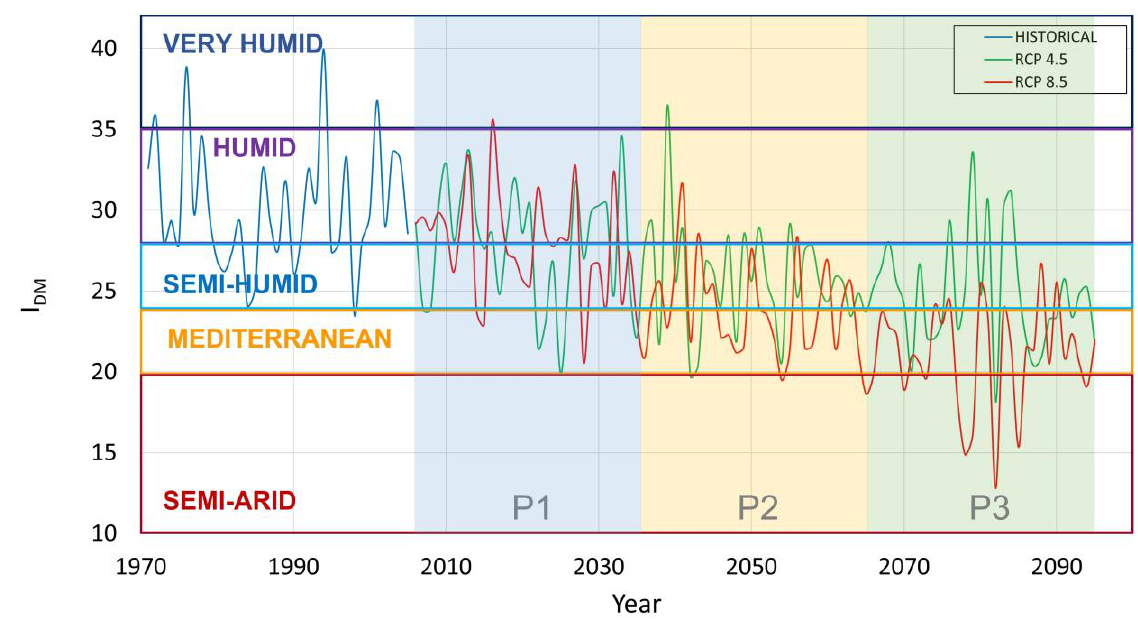
Figure 3. Temporal evolution of the De Martonne aridity index (I DM ) during the historical period, blue line, and the near future (P1), 2006–2035, the mid-century (P2), 2036–2065, and the end of the century (P3), 2066–2095, under the RCP4.5, green line, and RCP8.5, red line, scenarios.